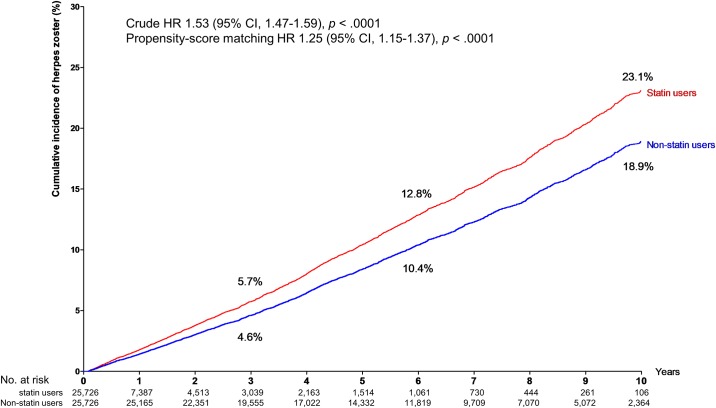
Cumulative incidences of herpes zoster (%) according to the use of statins.Kaplan–Meier curves showing cumulative incidences (%) of individuals suffering from herpes zoster. Red line indicating herpes zoster in statin users. Blue line depicting herpes zoster in non-statin users. The difference between statin users and non-statin users was significant (p < .0001 by the log rank test).